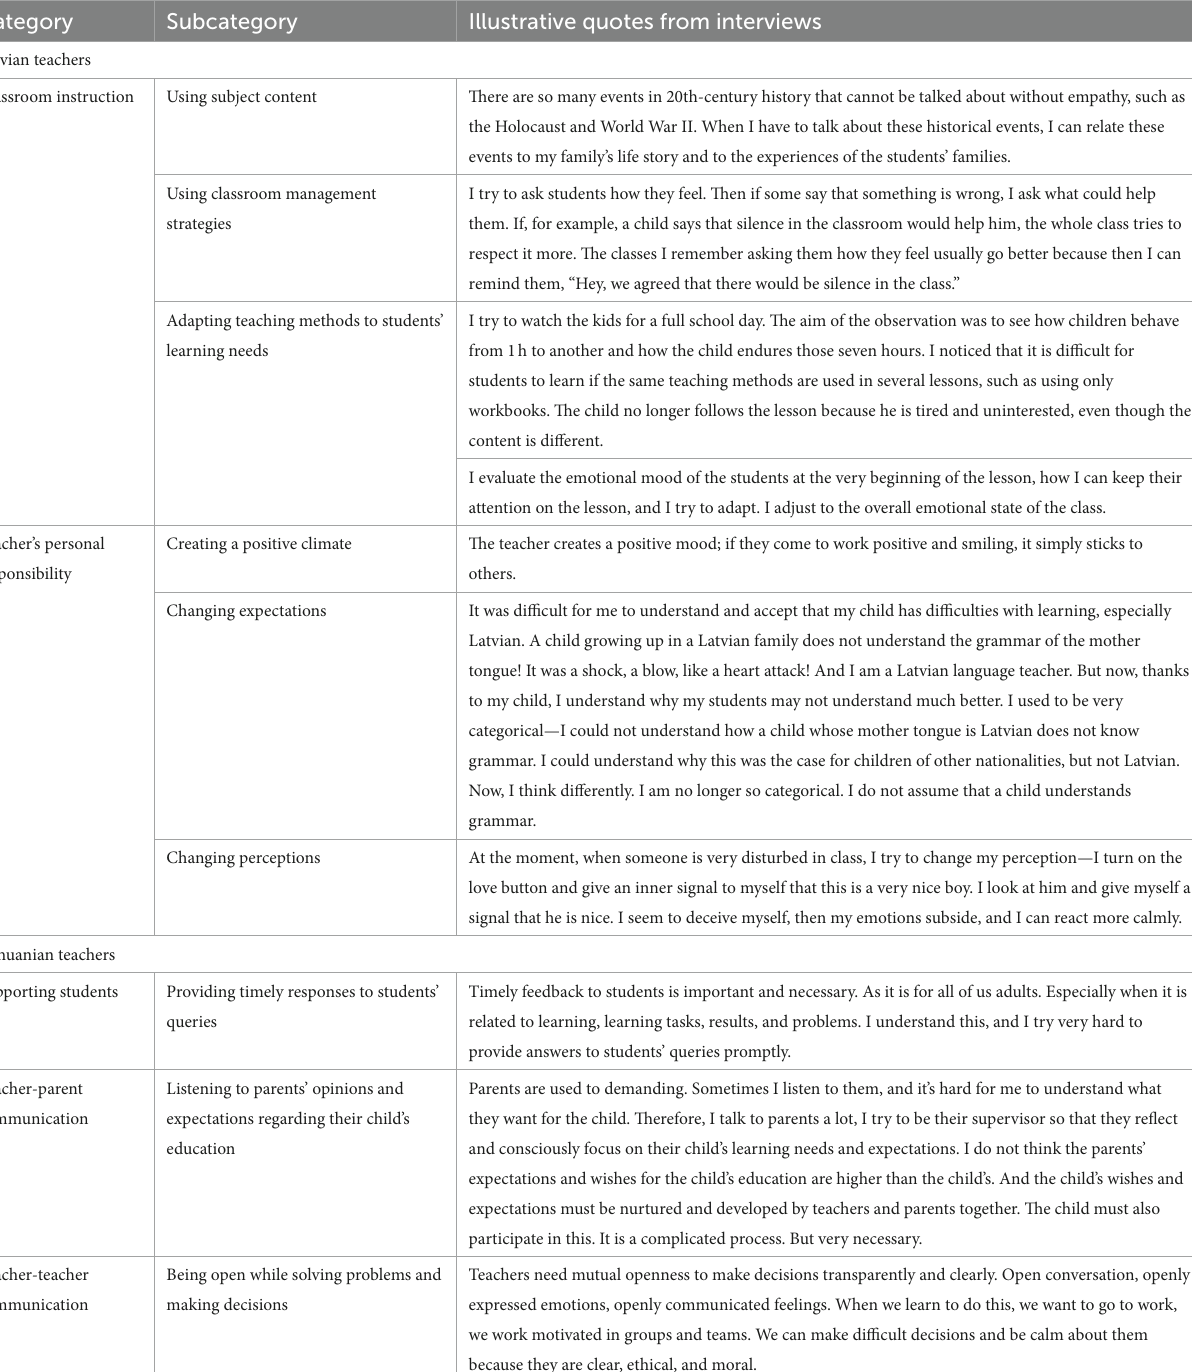
TABLE 4 Content of different categories in Latvian ( n = 83) and Lithuanian ( n = 69) teachers’ answers to the question “How do you use empathy in your work?” Category Subcategory Illustrative quotes from interviews Latvian